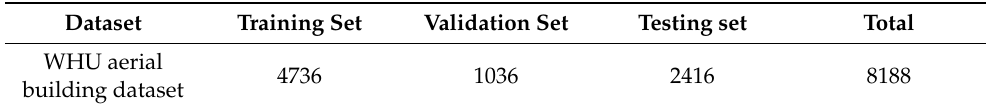
Table 1. The number of tiles in the training set, validation set, and testing set of the WHU aerial building dataset.